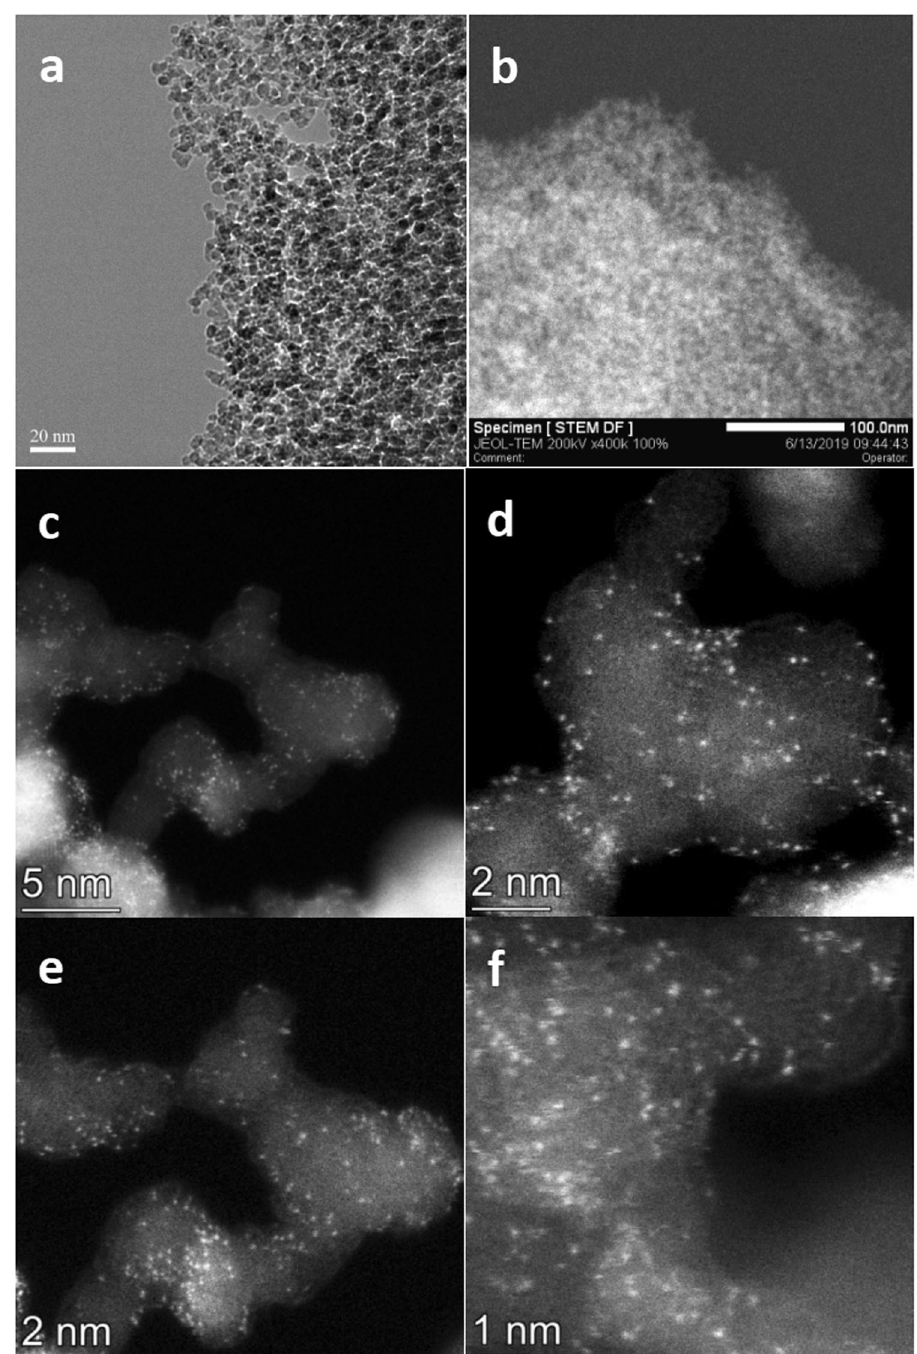
Fig. 3 Structure and Morphology characterization of Rh1/PNP-ND. a TEM image. b HAADF-STEM image. c – f AC-HAADF-STEM